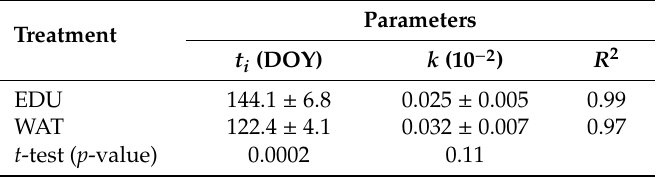
Table 1. Comparison between parameters of Gompertz function for WAT (water treated) and EDU (EDU treated) trees. t i , inflection point; k , rate of change of curve and time; R 2 , coe ffi cient of